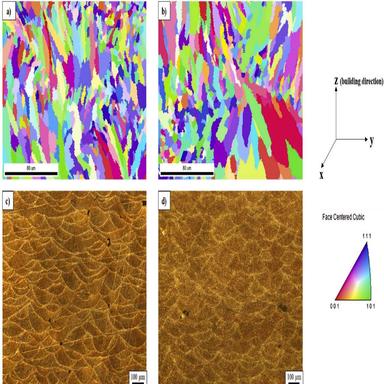
Inverse pole figure (IPF) orientation maps and optical microscopy images of the a&c) as-built and b&d) heat-treated samples.